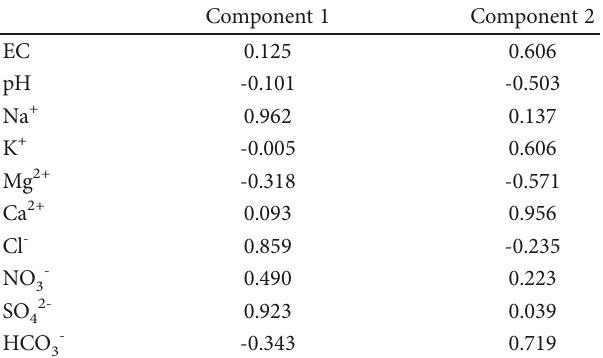
Table 4: R-mode factor analysis results.